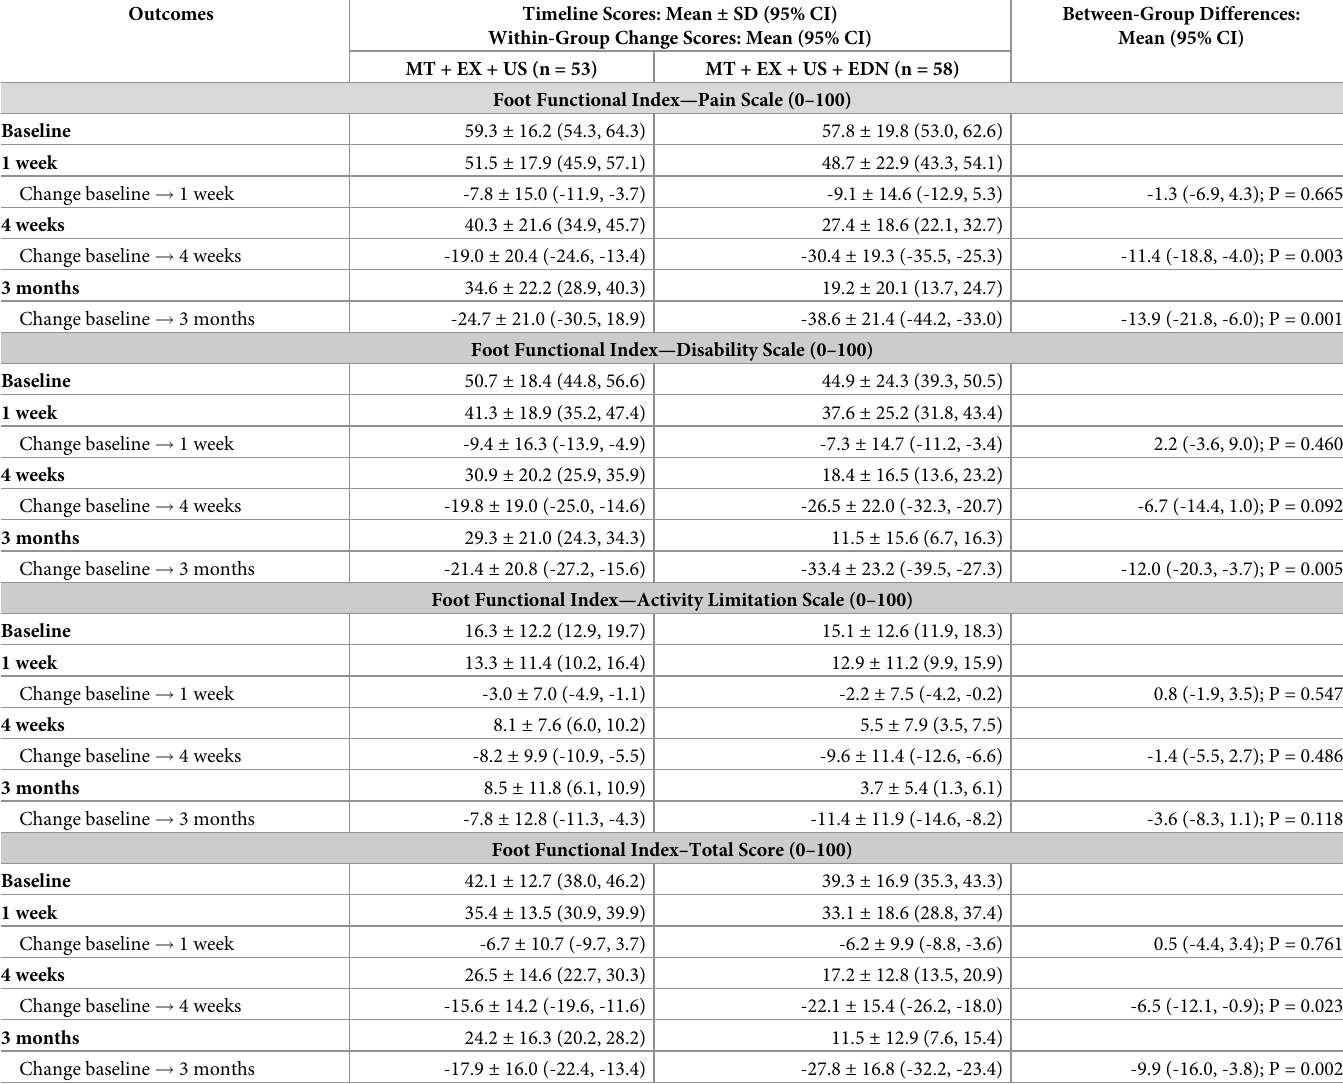
Table 2. Foot Functional Index (FFI) within-group and between-groups mean scores by randomized treatment assignment. Outcomes